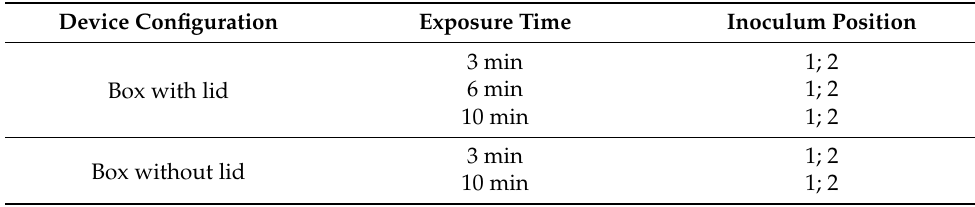
Table 1. Schematic procedure of the UV device